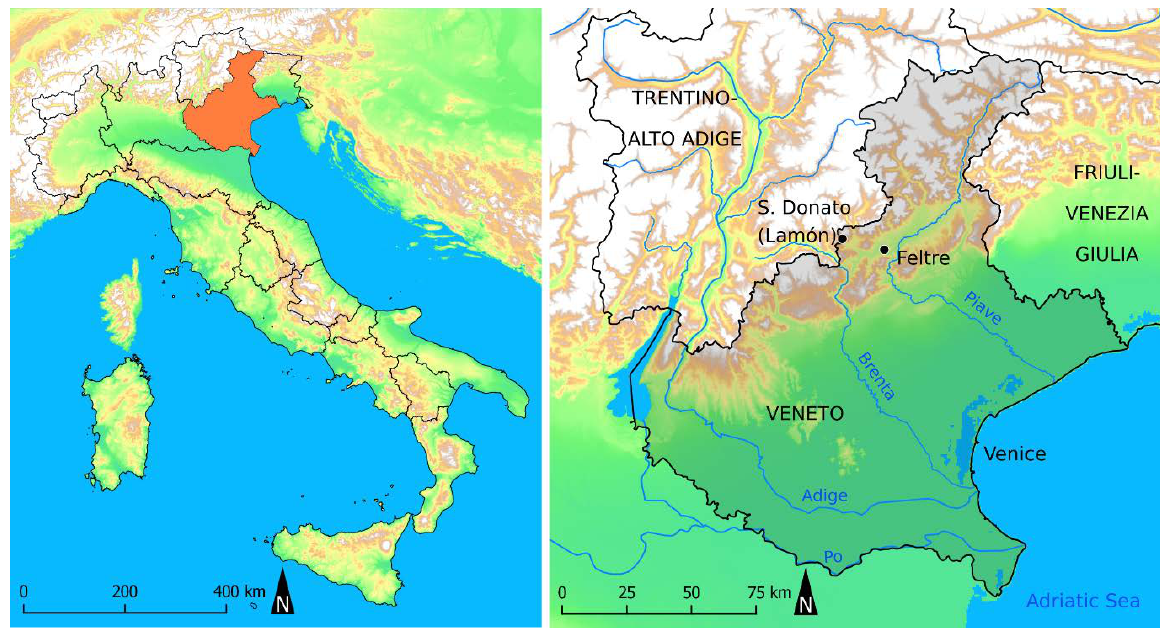
Figure 1. Veneto region in northern